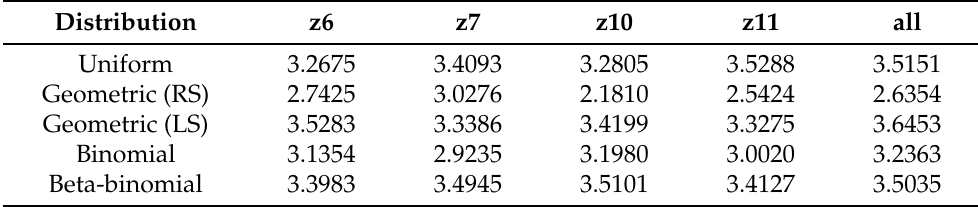
Table 1. Trimmed mean gap size values of 100 independent runs of the in silico experiments in the case of d = 2 and O / R = 5 evaluated for each initial rod length distribution, for each of the four central zones, as well as for the entire assembly.